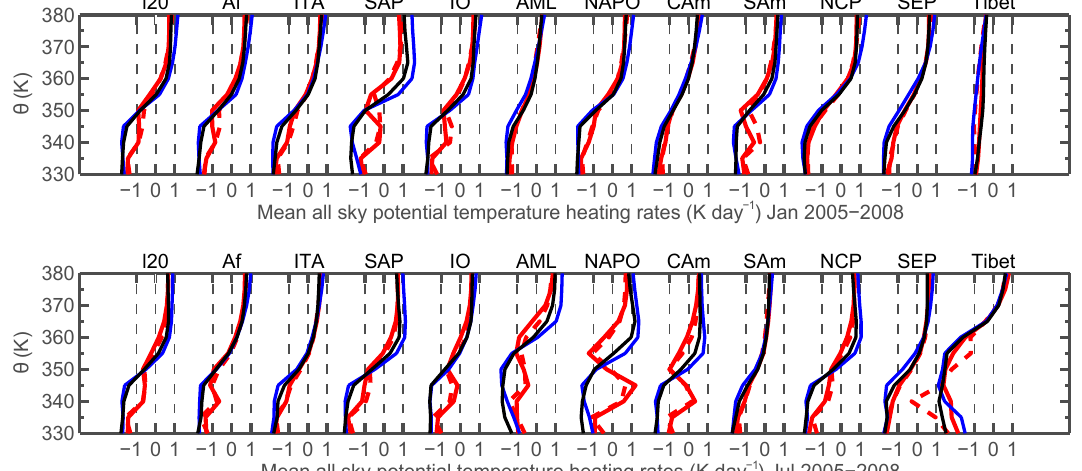
Figure 9. Mean heating rate profiles, as a function of potential temperature, for the four reanalyses: ERA-Interim (blue), MERRA (red), MERRA2 (dashed red) and JRA-55 (black), in K − 1 day − 1 . The upper panel is for January and the lower panel is for July, averaged over 2005–2008. Curves are plotted for each region defined on Fig. 1. The region “l20” represents the 20 ◦ S–20 ◦ N band. ↓ ↑ fluxes, M , can be separated according to the and M kine kine sign of the monthly average term under the integral Eq.